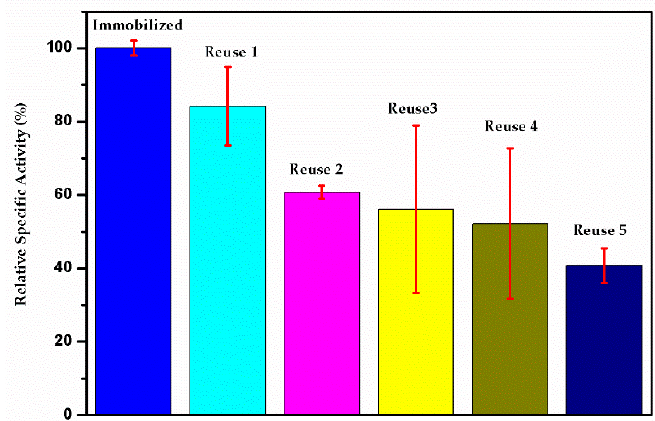
Figure 7. Reusability of immobilized GAD: relative specific activity of immobilized GAD.